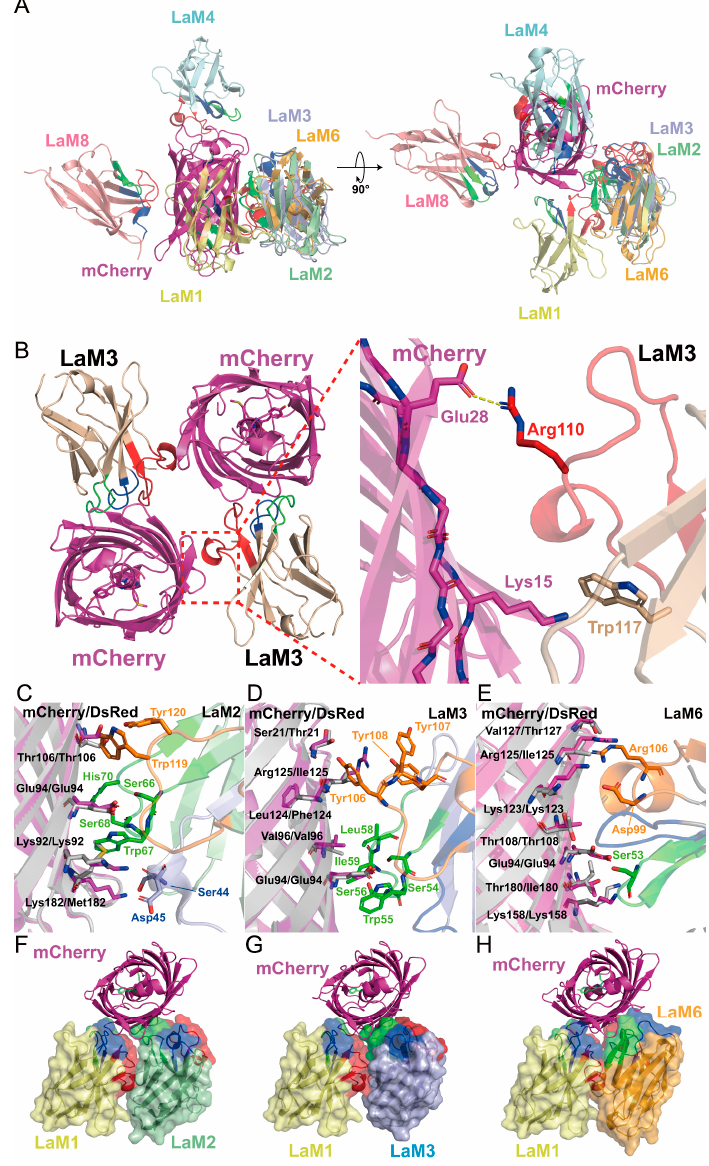
Figure 6. ( A ) Aligned structures of mCherry with LaM nanobodies. Structures of complexes from PDB and in this article were aligned to mCherry (PDB ID: 2H5Q) by Pymol. The mCherry is shown as magenta, LaM1 is pale yellow, LaM2 (PDB ID: 6IR2) is pale green, LaM3 is light blue, LaM4 (PDB ID: 6IR1) is pale cyan, LaM6 (PDB ID: 7SAL) is bright orange, and LaM8 is salmon. CDR1 is in blue, CDR2 is in green, and CDR3 is in red. ( B ) Detailed interaction of tetramer of (mCherry-LaM3) 2 . The left subfigure is an overview of the tetramer of (mCherry-LaM3) 2 , and the right subfigure is the interaction between LaM3 and mCherry, forming a tetramer. Of LaM3, CDR3 is shown in red, non-hypervariable region is shown in light orange. Key residues are shown as sticks, in which atom N is in blue and atom O is in red. ( C , E ) Interaction between LaM2, LaM3, or LaM6 binding to mCherry or DsRed. DsRed (PDB ID: 1ZGO), a complex of mCherry-LaM2, mCherry-LaM3, and mCherry-LaM6, was aligned to mCherry. CDR1 is shown in light blue ( C ) or blue ( D , E ), CDR2 is green, CDR3 is orange, mCherry is magenta, and DsRed is silver. Key residues involving interaction are shown as sticks. ( F – H ) Structures of mCherry-LaM1 aligned to mCherry-LaM2, mCherry-LaM3, and mCherry-LaM6. The surface of LaMs is shown transparently, mCherry is in magenta, LaM2 in pale green, LaM3 in light blue, and LaM6 in bright orange. CDR1 in blue, CDR2 in green, and CDR3 in